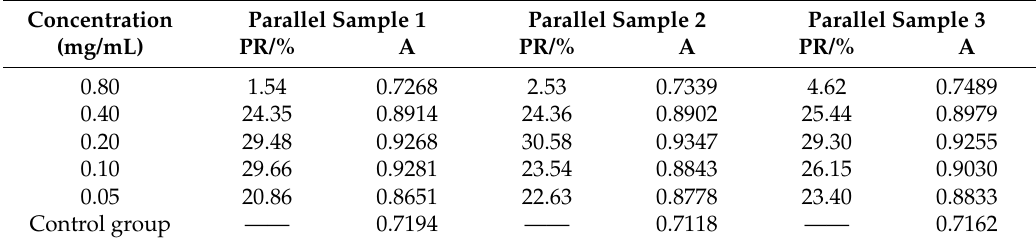
Table 4. Effect of polysaccharide concentration on mouse spleen cell proliferation.